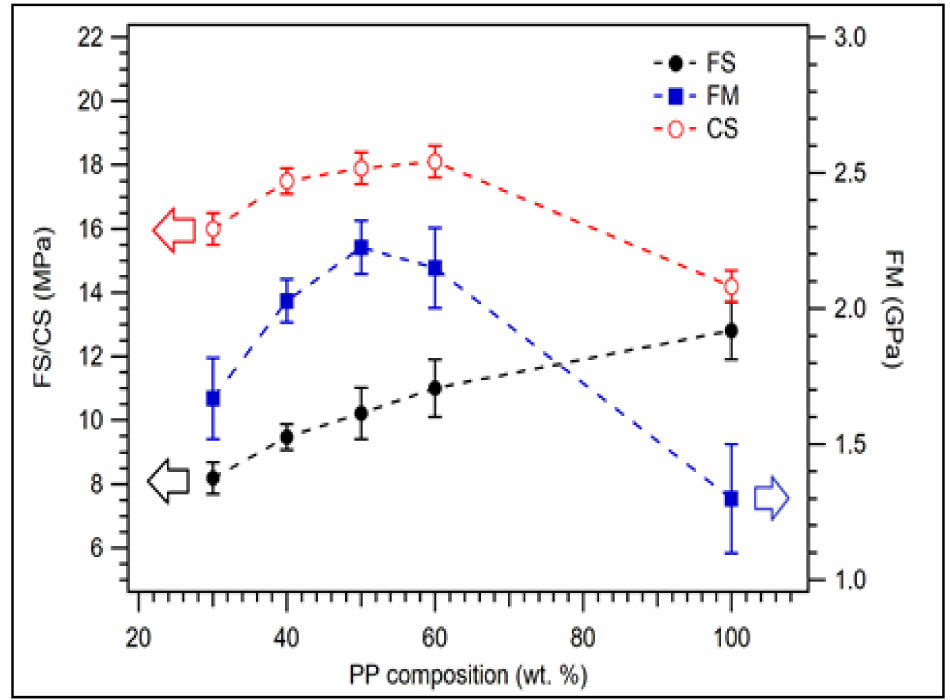
Figure 3. Flexural properties of coconut shell biocomposite for various PP compositions with 200 mesh of coconut shell